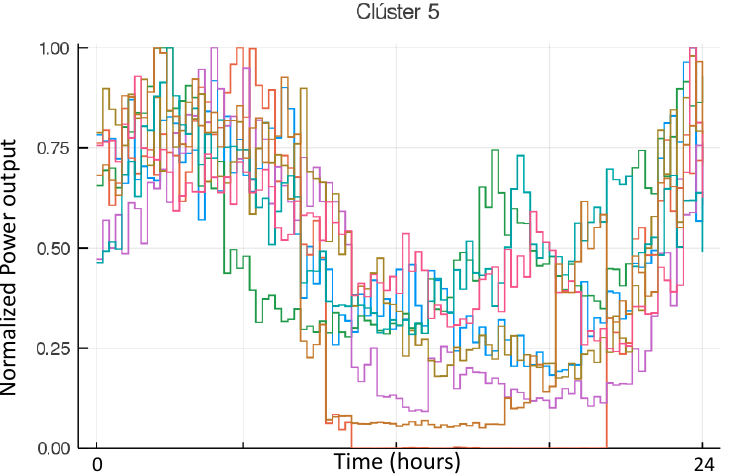
Figure 10. Data of 362 actual distribution customers from Santiago, Chile. Cluster